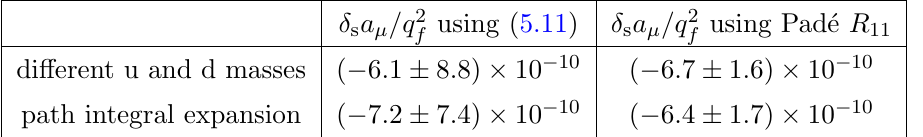
Table 8 . Strong isospin breaking correction to a (cid:22) . The middle column shows results using equa- tion (5.11) to obtain ^(cid:5)( ^ Q 2 ), the right column results using Pad(cid:19)e R 11 . The results for the strong isospin breaking correction to a (cid:22) are given in table 8. Using the Pad(cid:19)e (cid:12)ts we are able to resolve the strong isospin breaking correction to a (cid:22) .